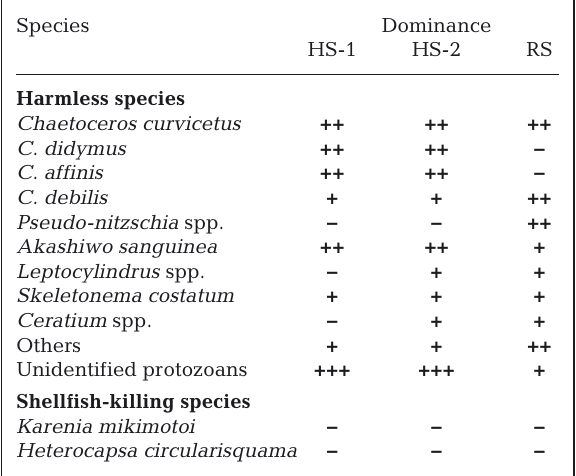
Table 3. Phytoplankton and protozoan composition during the oxycline persistence. HS-1: hypoxic site 1; HS-2: